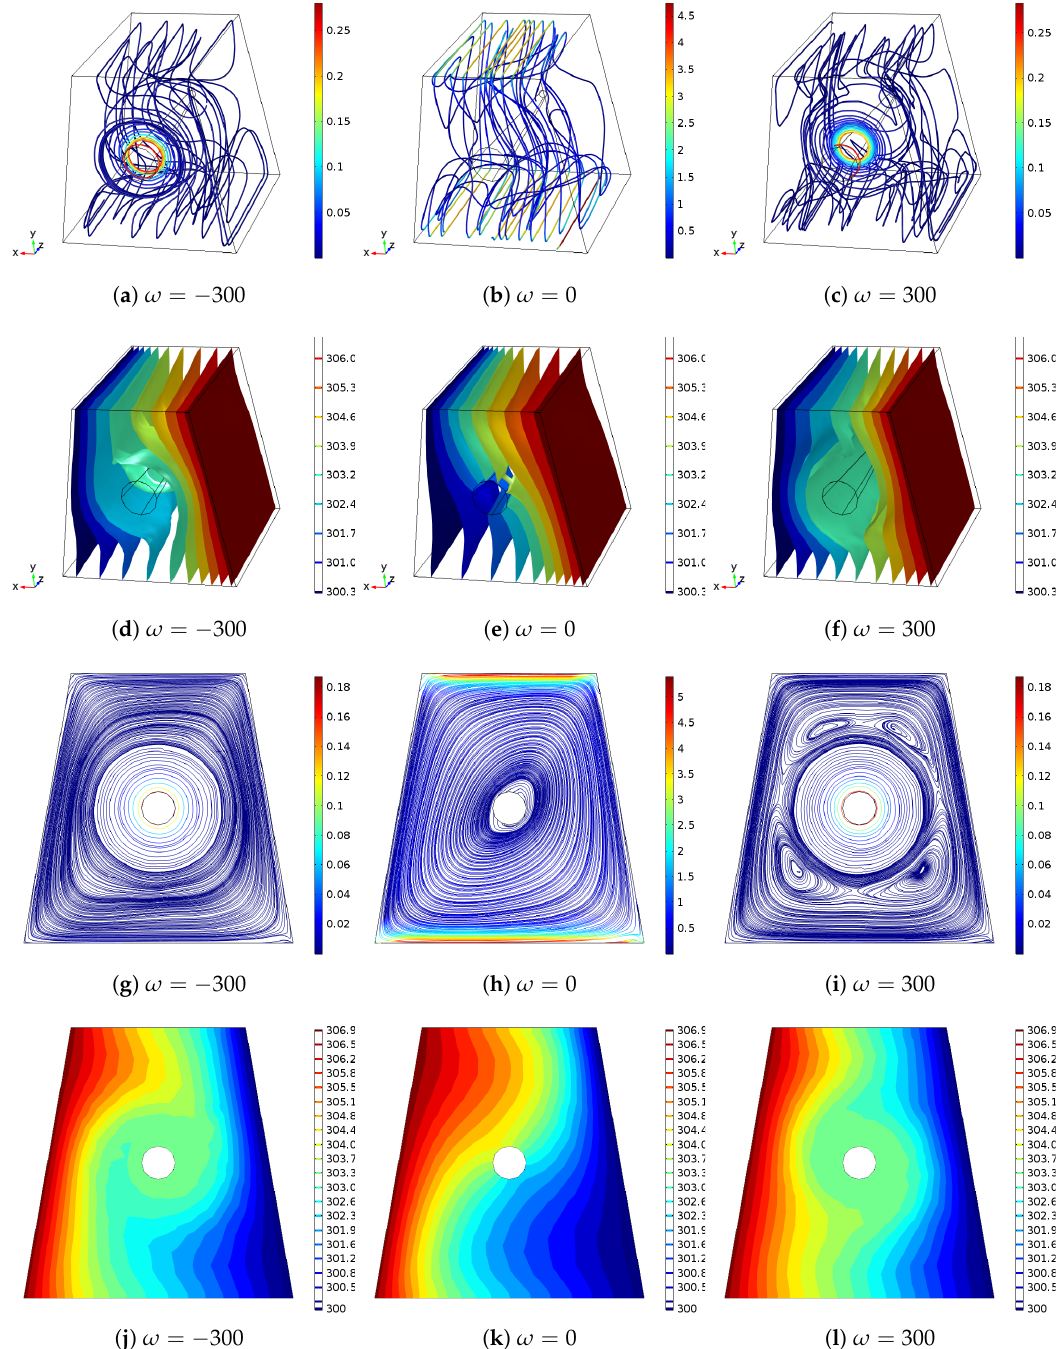
Figure 4. Effects of angular rotational speed of the rotating cone on the variation of flow and thermal patterns for 3D and 2D mid-plane of the cavity (Ri = 5, Ha = 10, Da = 10 − 3 , AR = 0.25, x 0 = 0.5 H, φ =